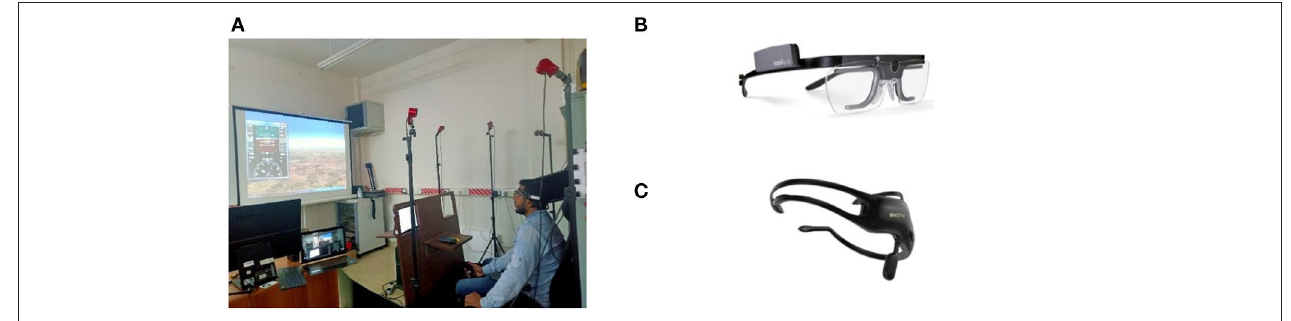
FIGURE 4 | Apparatus. (A) Flight simulator setup. (B) Eye gaze tracker from Tobii [courtesy (14)]. (C) EEG headset from Emotiv [courtesy (15)].